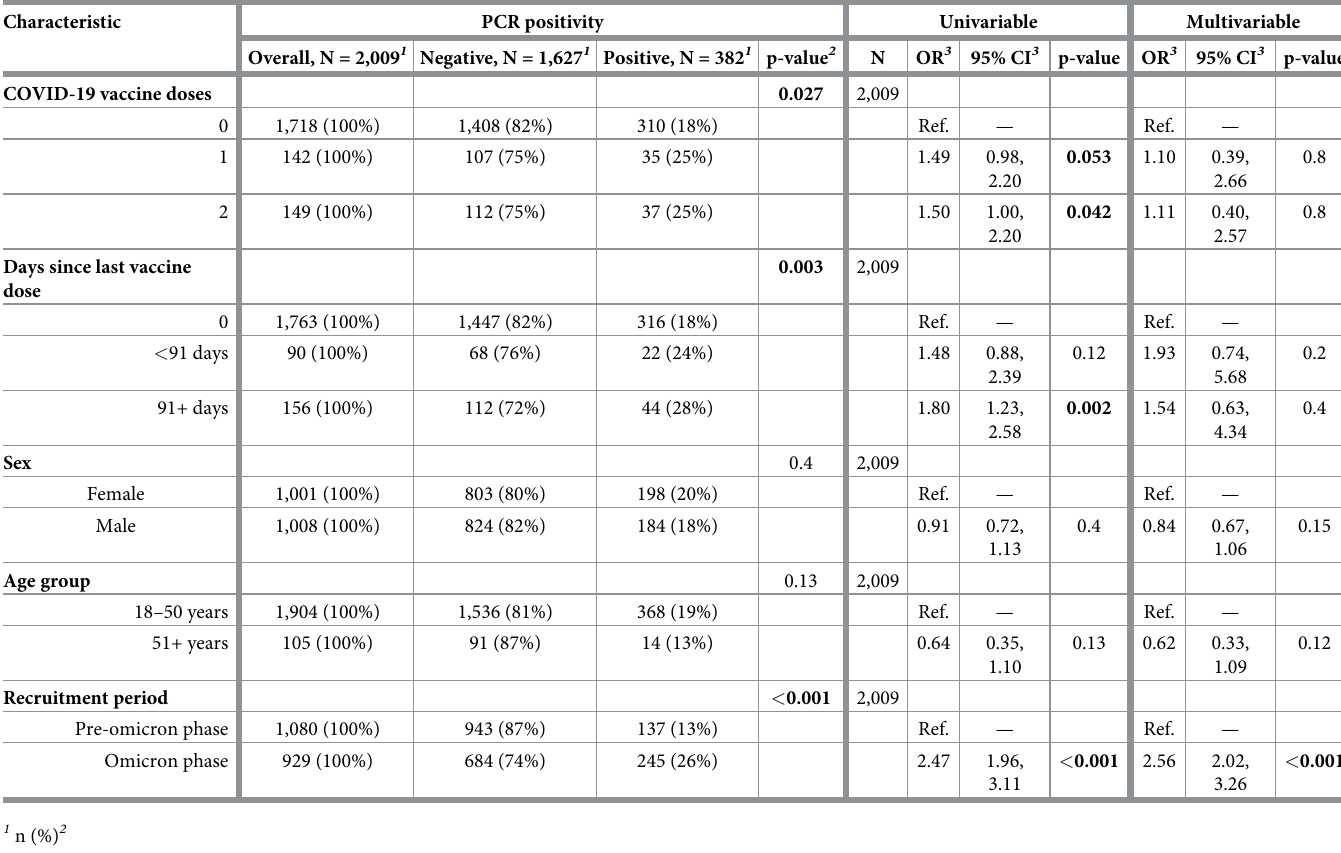
Table 4. COVID-19 vaccination and the risk of PCR-confirmed SARS-CoV-2 infection.